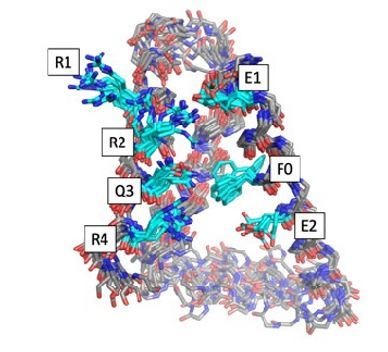
XplorNIH NMR ensemble prior to MD refinement displaying the orientation of the key sidechain residues.The S0 and S1 helices are not shown to improve clarity.